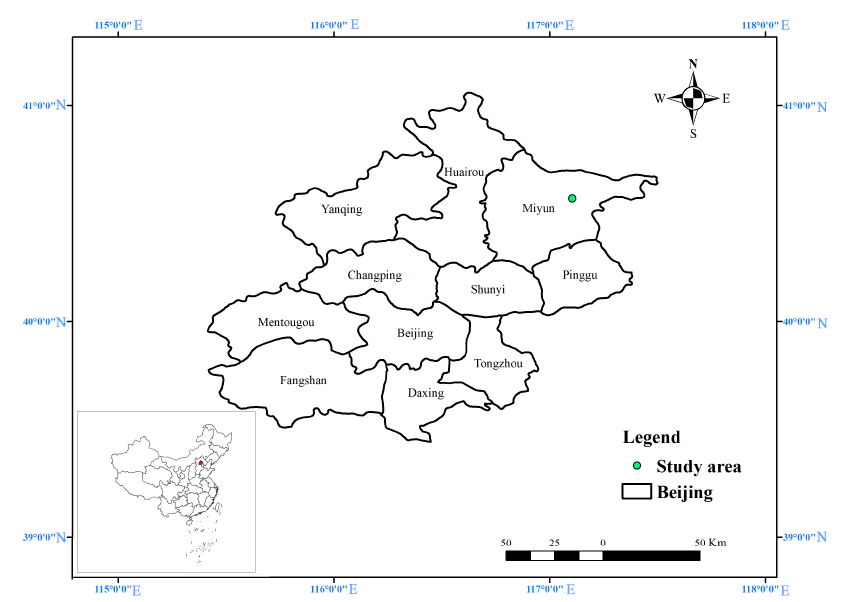
Figure 6. Location map of runoff plots.